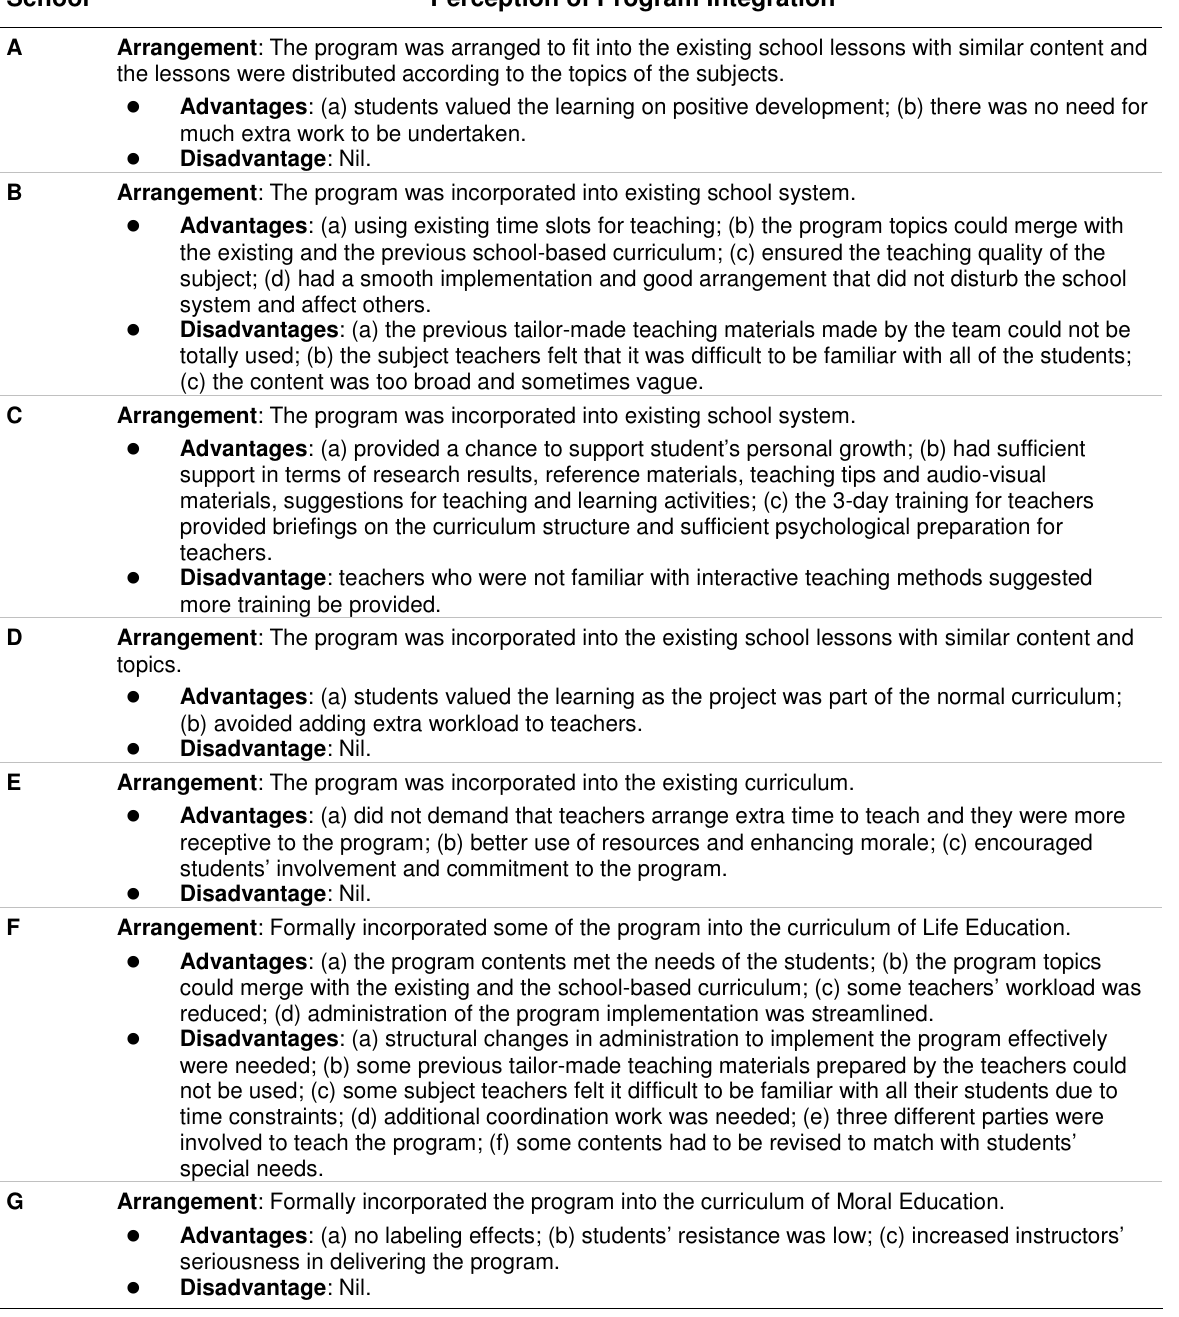
Perception of Program Integration School